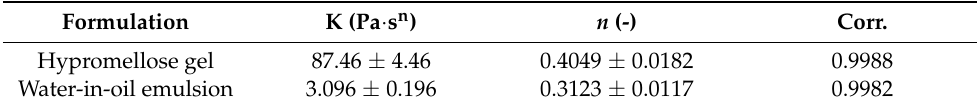
Figure 1. Viscosity curves of the gentamicin and vancomycin-loaded hypromellose gel (cross) and water-in-oil emulsion (triangle). Table 1. Coefficients of consistency (K) and indexes of the flow behaviors n of the gentamicin and vancomycin-loaded hypromellose gel and water-in-oil emulsion.